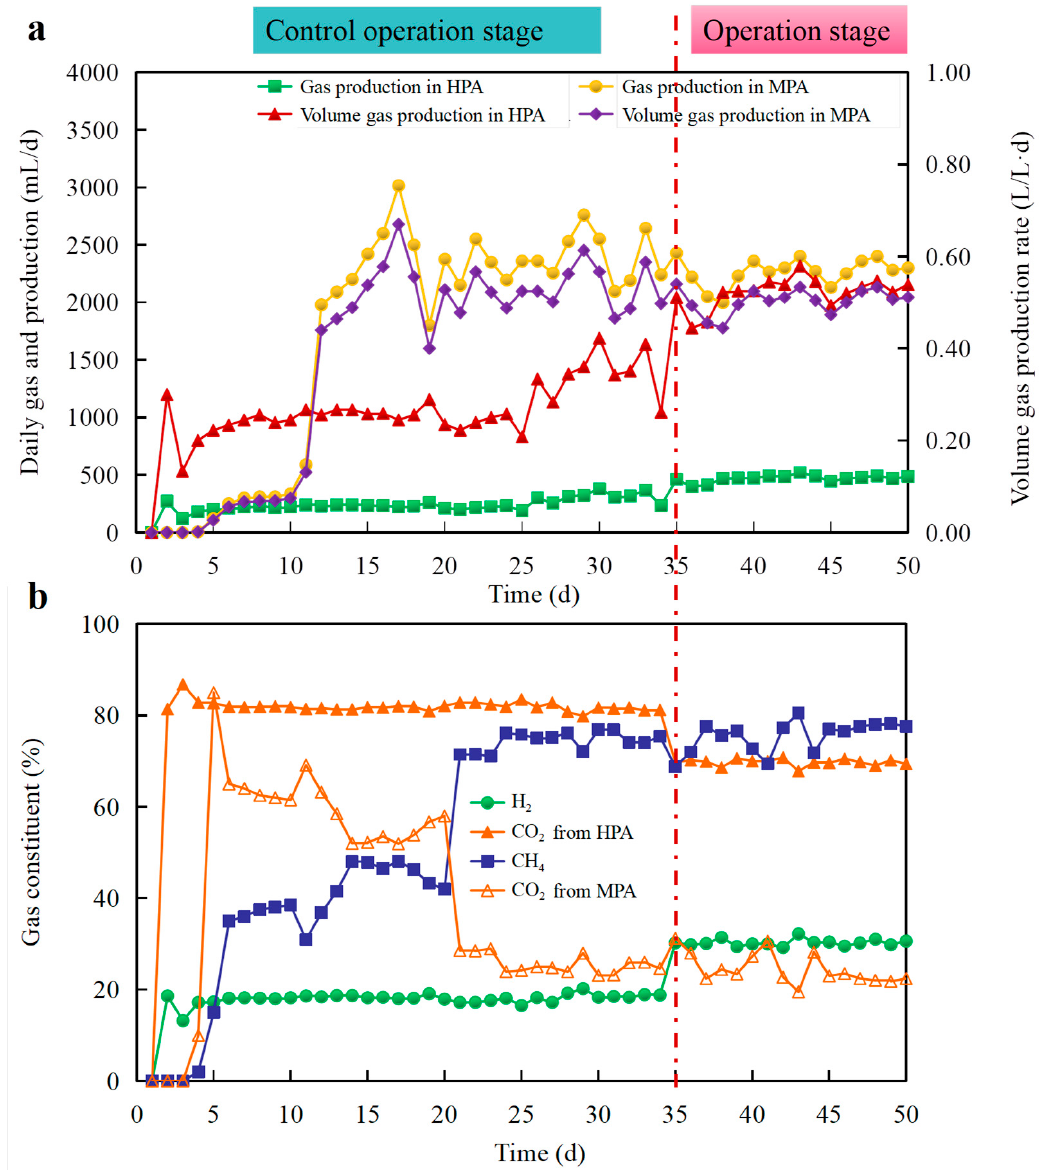
Figure 3. Performance of biohythane production from rice straw. ( a ) Continuous gas production; ( b ) variation in H 2 , CH 4 , and CO 2 content in produced gas.